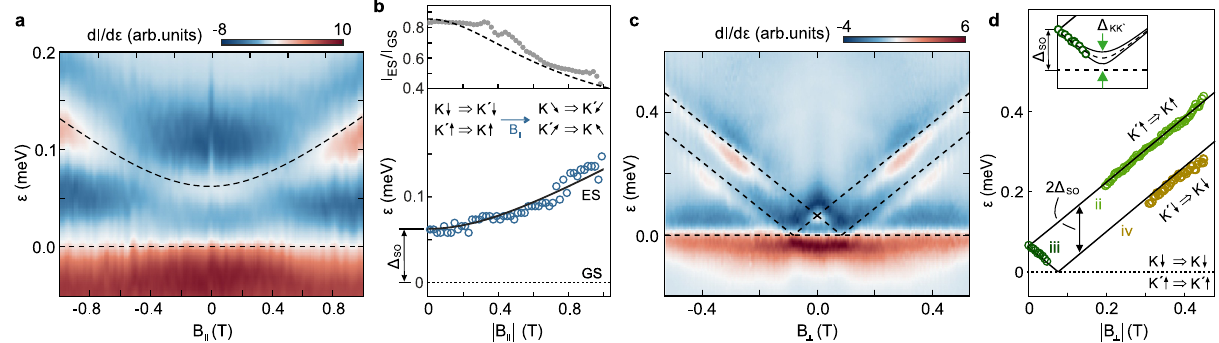
Fig. 4 Magnetospectroscopy measurements. a Magnetotransport measurements showing dI / d ε as function of detuning energy and in-plane B - fi eld. The horizontal dashed line marks the ground state (GS) transition ( ε = 0) and the curved line marks the excited state (ES) transition. b The upper panel shows the ratio of the ES current with respect to the GS current. From a simple projection model, we obtain the dashed line, which describes the expected decay in amplitude of the ES due to the spins tilting in-plane. c Similar data as in panel a but for out-of-plane B - fi eld. The dashed lines mark all transitions described in Fig. 3e. d Extracted transition energies as function of B ⊥ highlighting the transitions (ii), (iii) and (iv) (see labels). The inset shows a low-energy close-up around the transition (iii) highlighting the presence of a fi nite K (cid:2) K 0 mixing. The dashed line corresponds to transition energies, including a Δ KK 0 ¼ 20 μ eV. The solid lines below and above correspond to Δ KK 0 ¼ 10 μ eV and 30 μ eV,